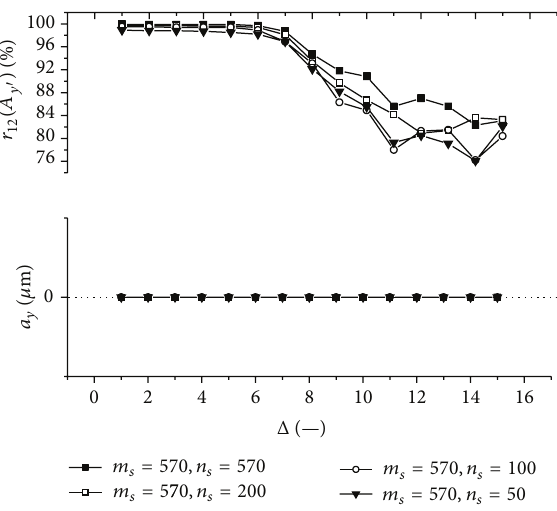
Figure 17: The evaluated object’s translation component 𝑎 𝑦 as well as the maximum 𝑟 12 (𝐴 𝑦 󸀠 ) of the 1D normalized cross-correlation function of intensity signals 𝐼 1 and 𝐼 2 acquired from decimated 2D intensity signals of various size as a function of the factor Δ . Mean speckle sizes are 𝛼 𝑥 󸀠 = 133.6 𝜇 m and 𝛼 𝑦 󸀠 = 117.7 𝜇 m. The object is translated by 𝑎 𝑥 = 10 𝜇 m and 𝑎 𝑦 = 0 𝜇 m.